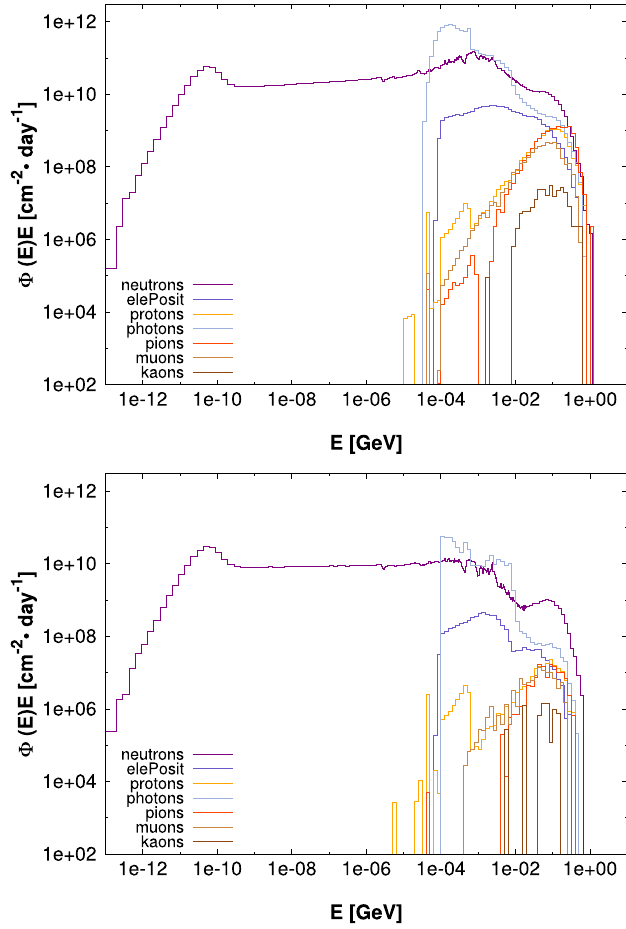
Fig. 2. Mixed- fi eld: simulated spectra (lethargy), position 1, cp_0000 and cp_CIIC con fi